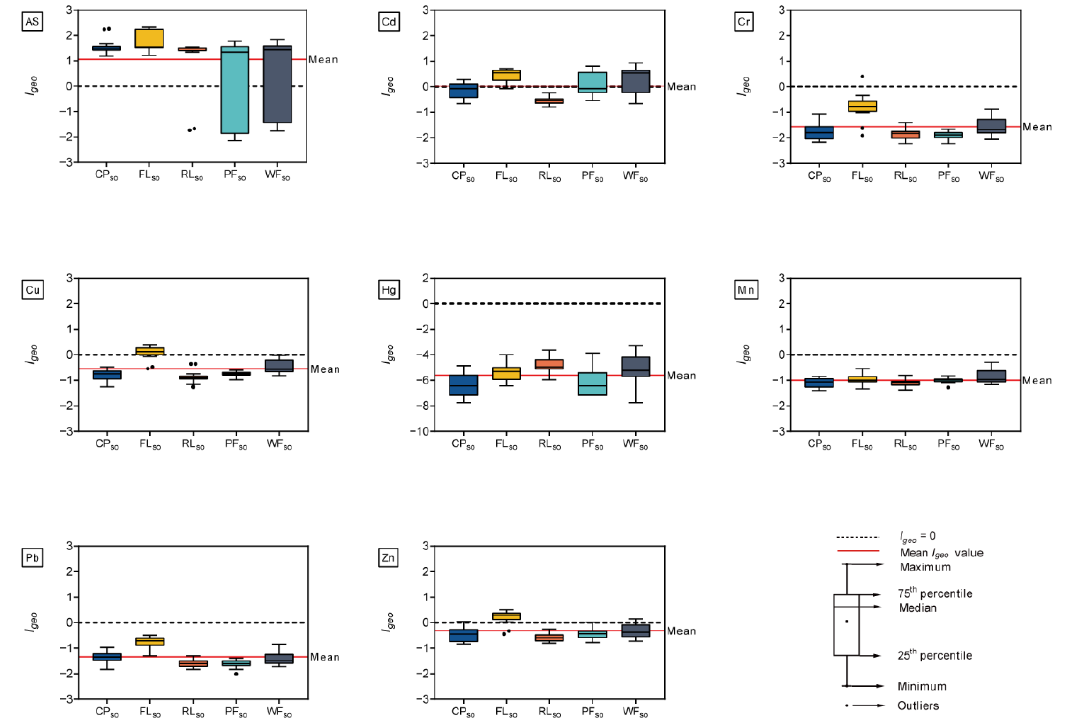
Figure 2. Box-plot of geo-accumulation index ( I geo ) of metals in the surface soil that were collected from CP so , FL so , RL so , PF so , and WF so . The red solid line represents the mean I geo values that were averaged across all types of land use, and the black dashed line represents I geo = 0.